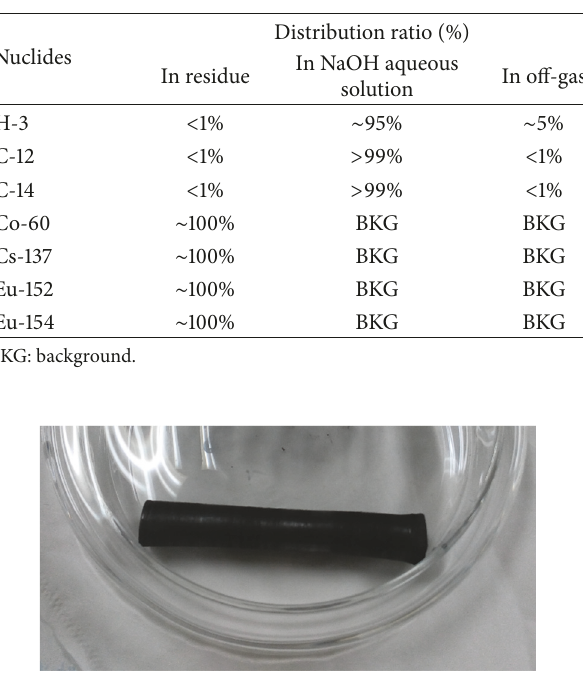
Table 1: Distribution ratios of nuclide after graphite combustion.